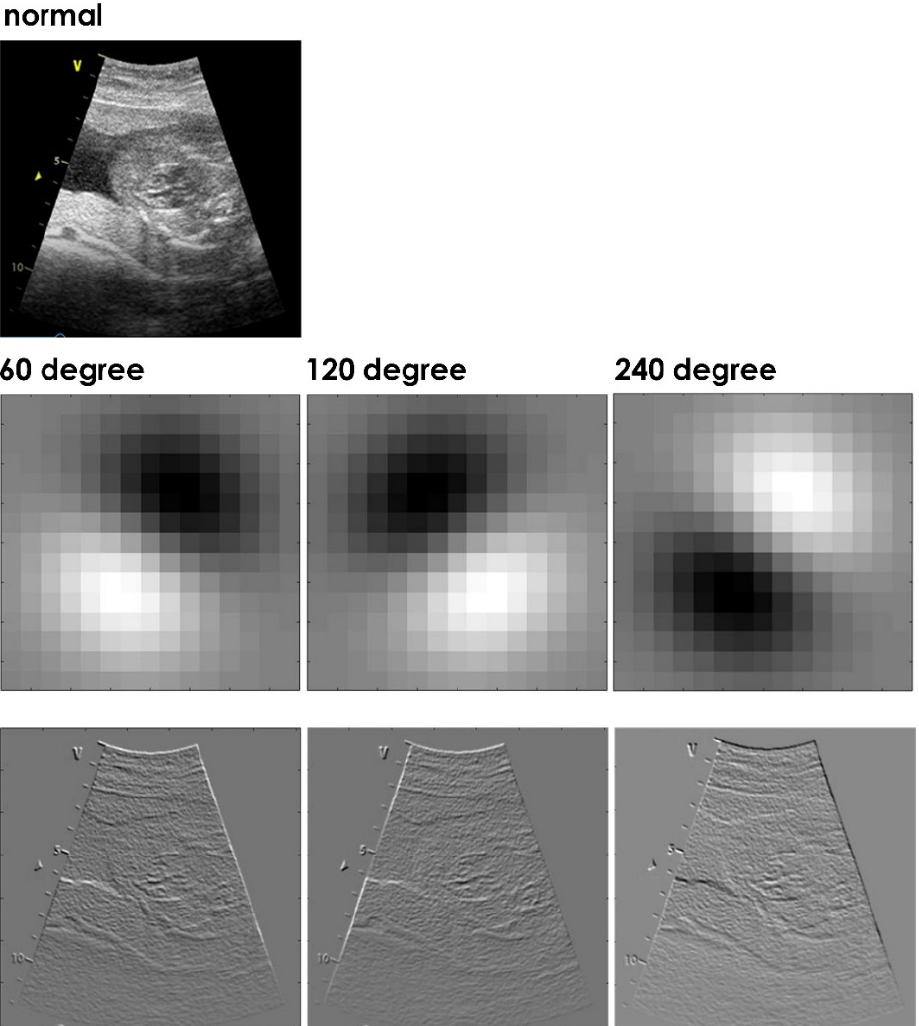
Figure 5. Steered filters (second row) and their application to a normal fetal 4-chamber US image (third row).